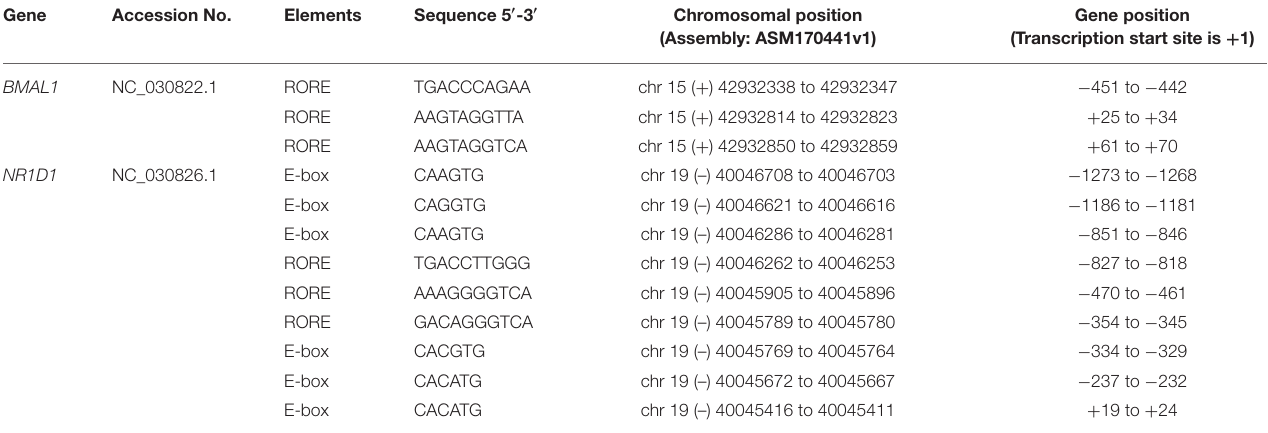
TABLE 4 | Location of putative clock-controlled elements at the promoters of goat genes investigated in the present study. Gene Accession